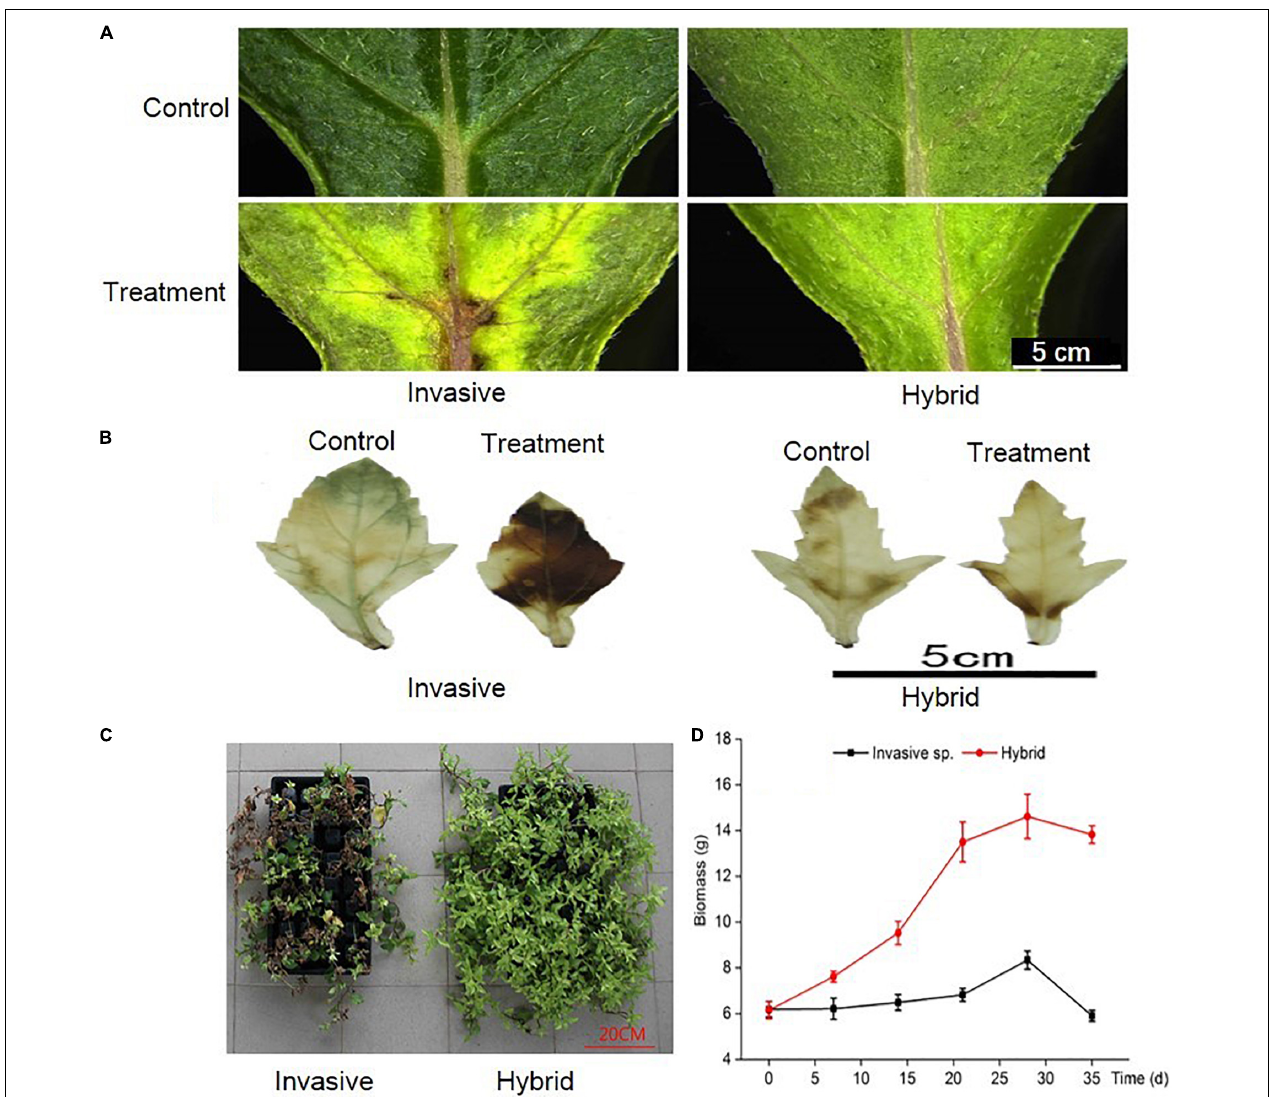
FIGURE 1 | Under Cd stress, the changes of two species in phenotypic of leaves (A) , location of reactive oxygen in leaves (B) , phenotypic of whole plant (C) , and biomass of whole plant (D)